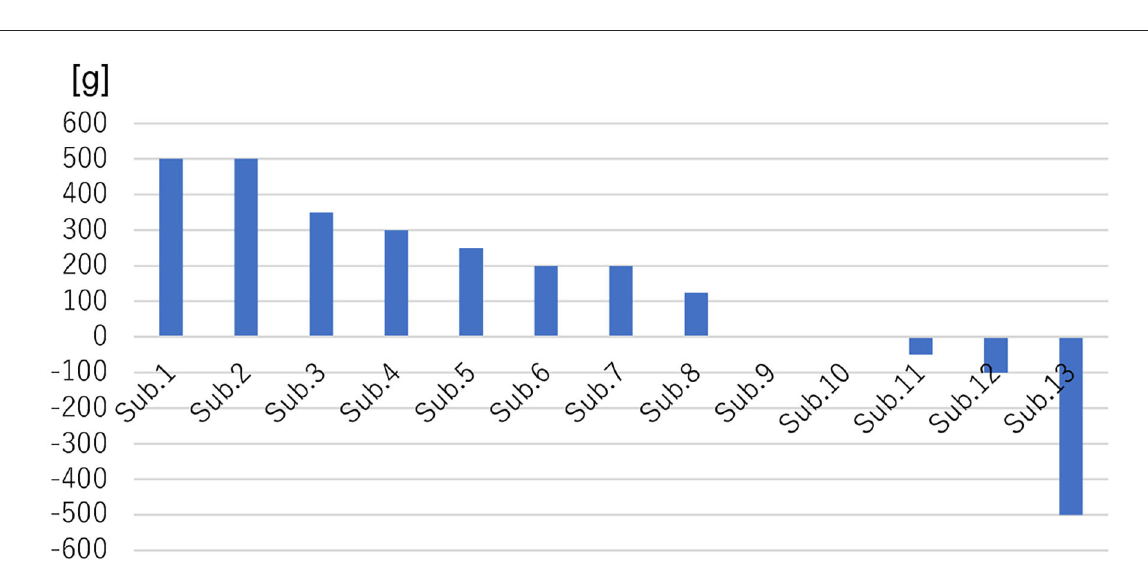
FIGURE6 Results of Experiment 1. Individual differences in changes in weight perception between sensor information conditions ( Futami et al.,